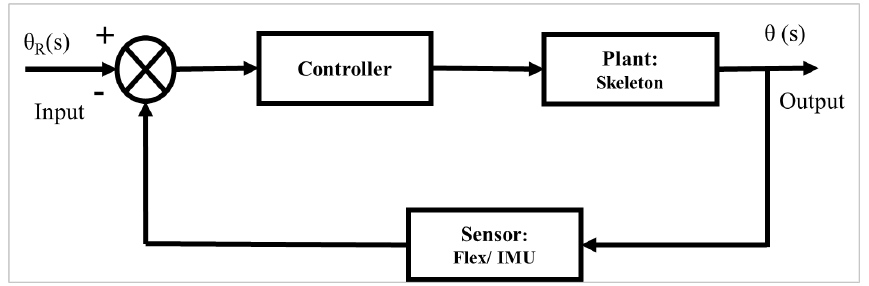
Figure 6. Feedback control system.